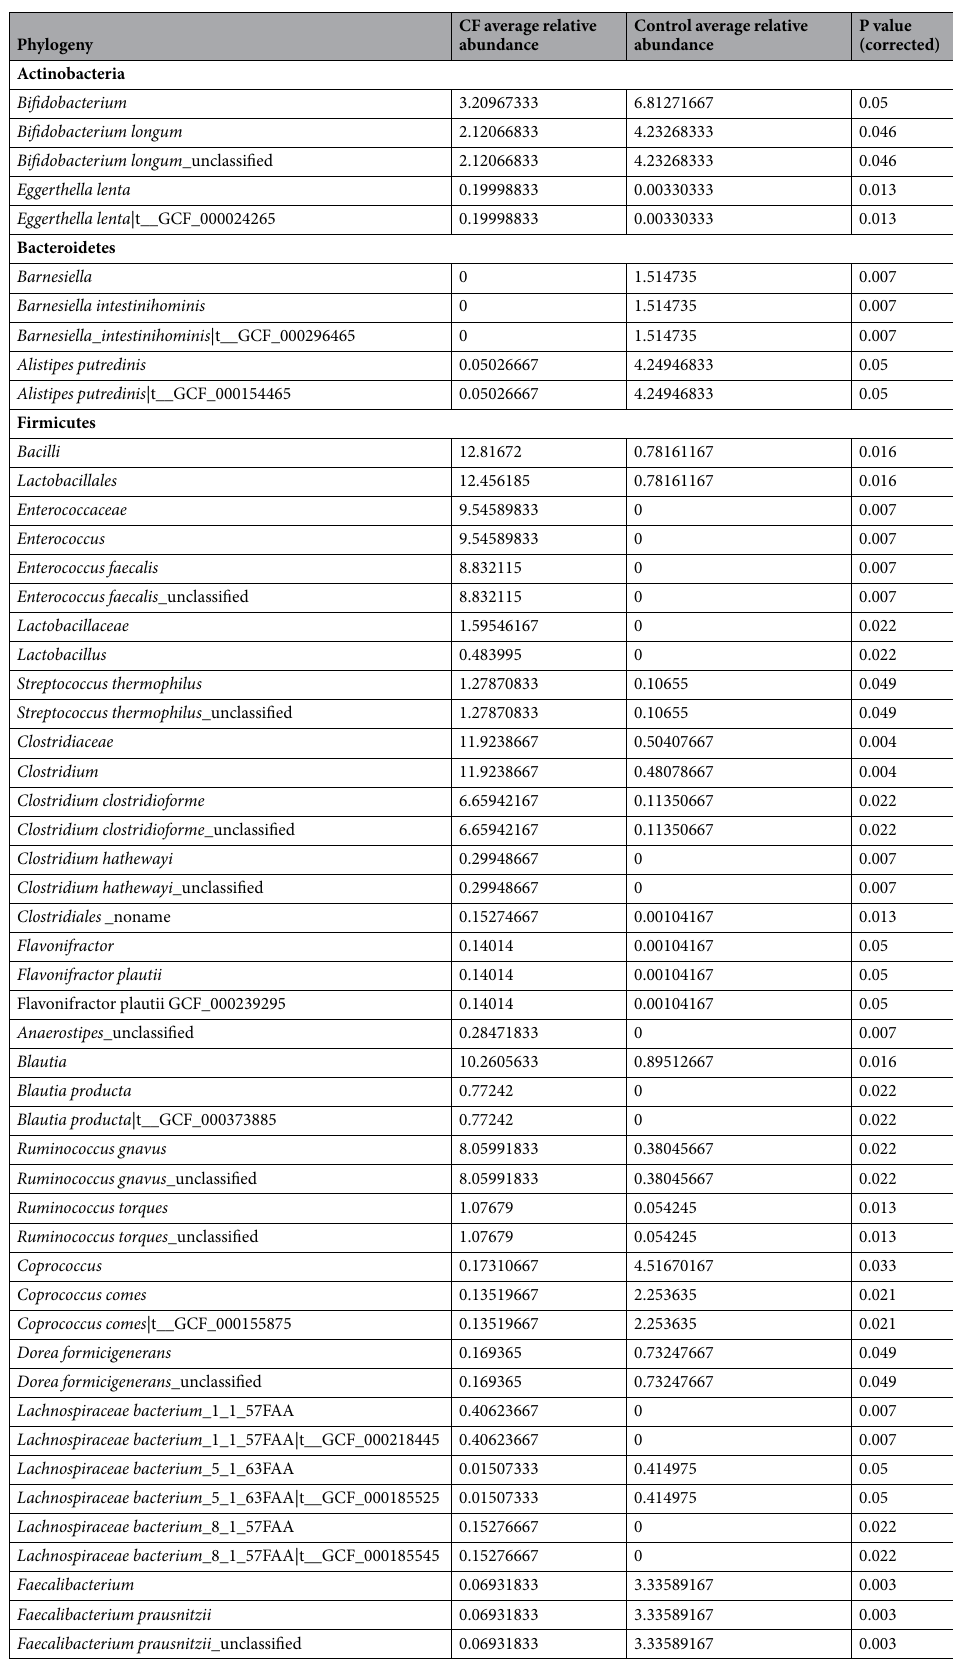
Table 1. Relative abundances of bacteria found at significantly different levels in the CF and control